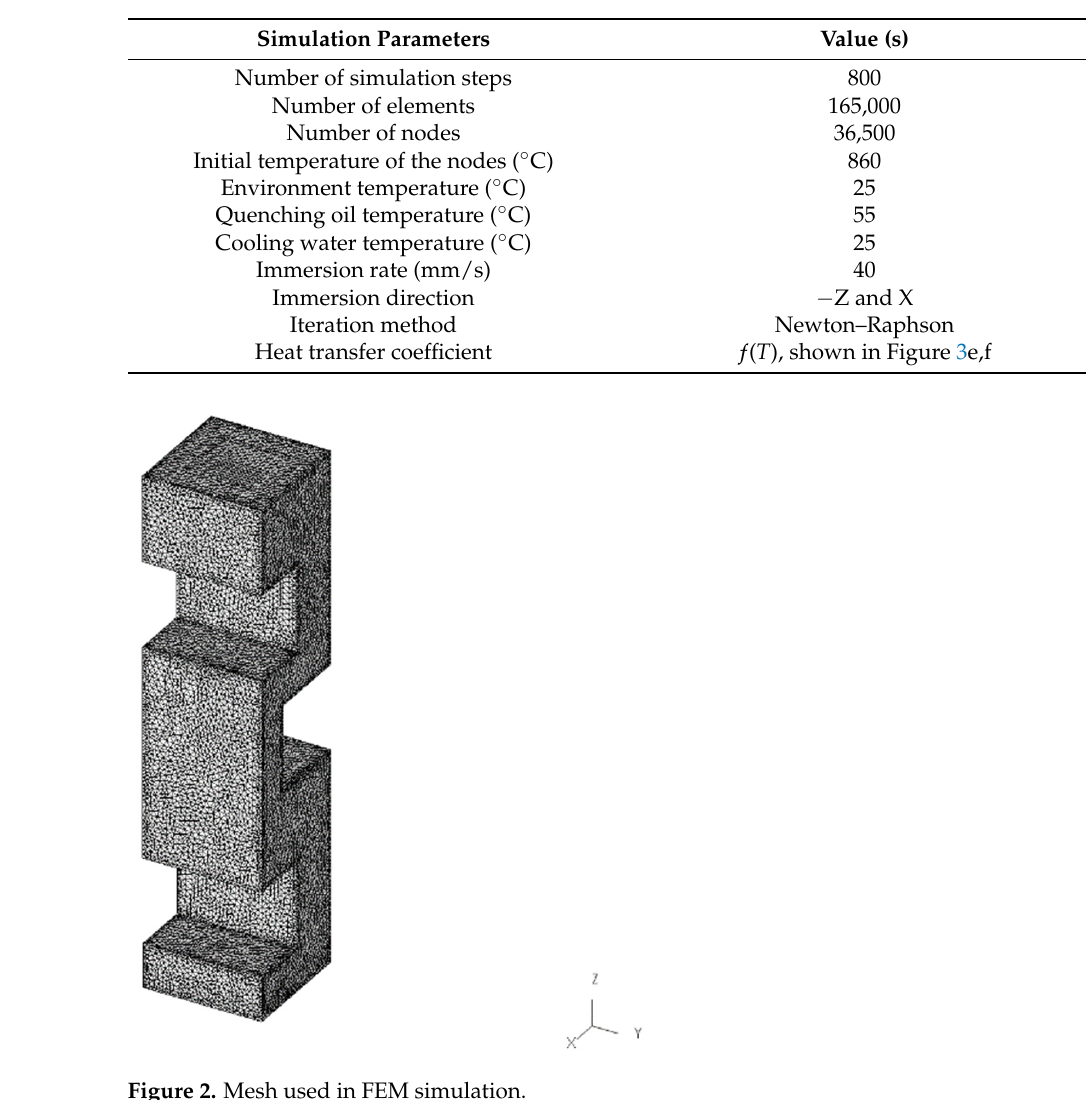
Table 3. Simulation parameters.